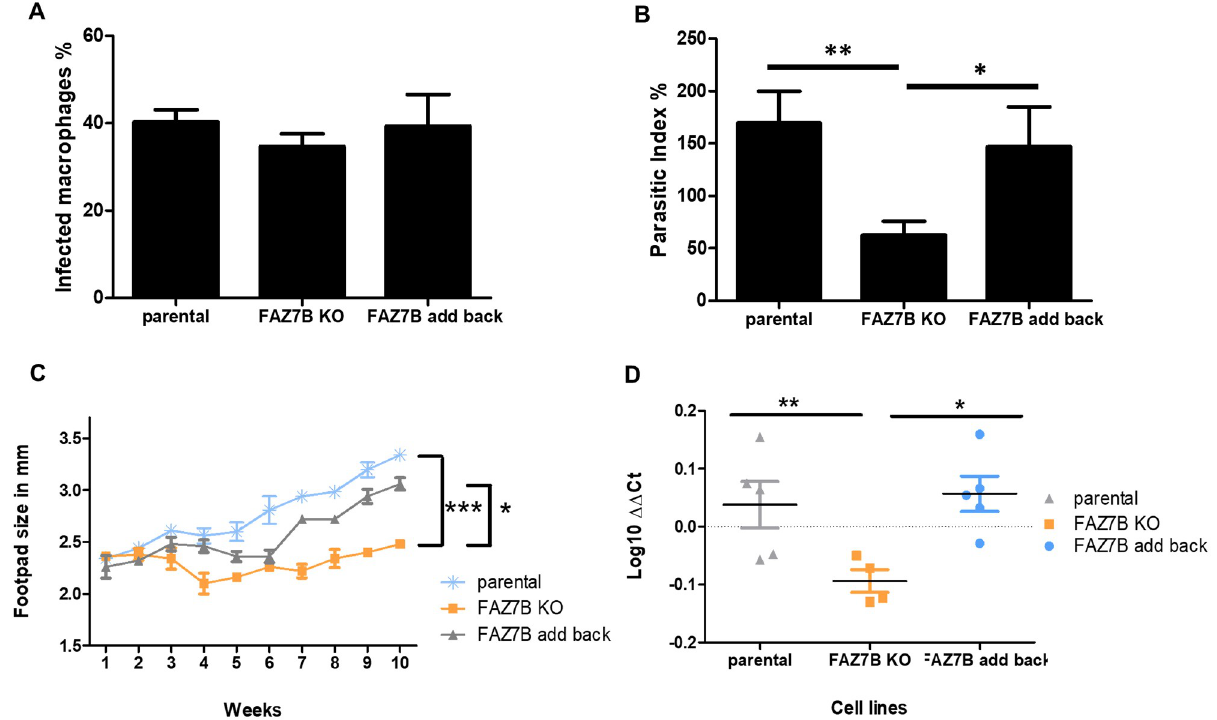
Fig 8. Loss of FAZ7B reduces pathogenicity in the mouse. (A-B) Axenic amastigotes of parental, FAZ7B KO and FAZ7B add-back cells were used to infect differentiated THP-1 monocytes. Percentage of infected macrophages (A) and parasitic index (B) were determined at 72h post infection by Giemsa staining as described in Experimental procedures. The parasitic index (PI) was defined as the percentage of infected macrophages x number of intracellular parasites/macrophage. �� p < 0.01, � p < 0.05. (C) Measurement of mean footpad lesion size during a ten-week infection time course with parental, FAZ7B KO and FAZ7B add-back stationary-phase promastigotes. Error bars represent SDs. The p value was calculated using two-tailed unpaired Student’s t -test comparing each cell line at week 10. ��� p < 0.001, � p < 0.05. (D) Relative amount of Leishmania DNA compared to mouse DNA by qPCR at 10 weeks post-infection by parental, FAZ7B KO and FAZ7B add-back cells. �� p < 0.01, � p < 0.05 (Student’s t -test).